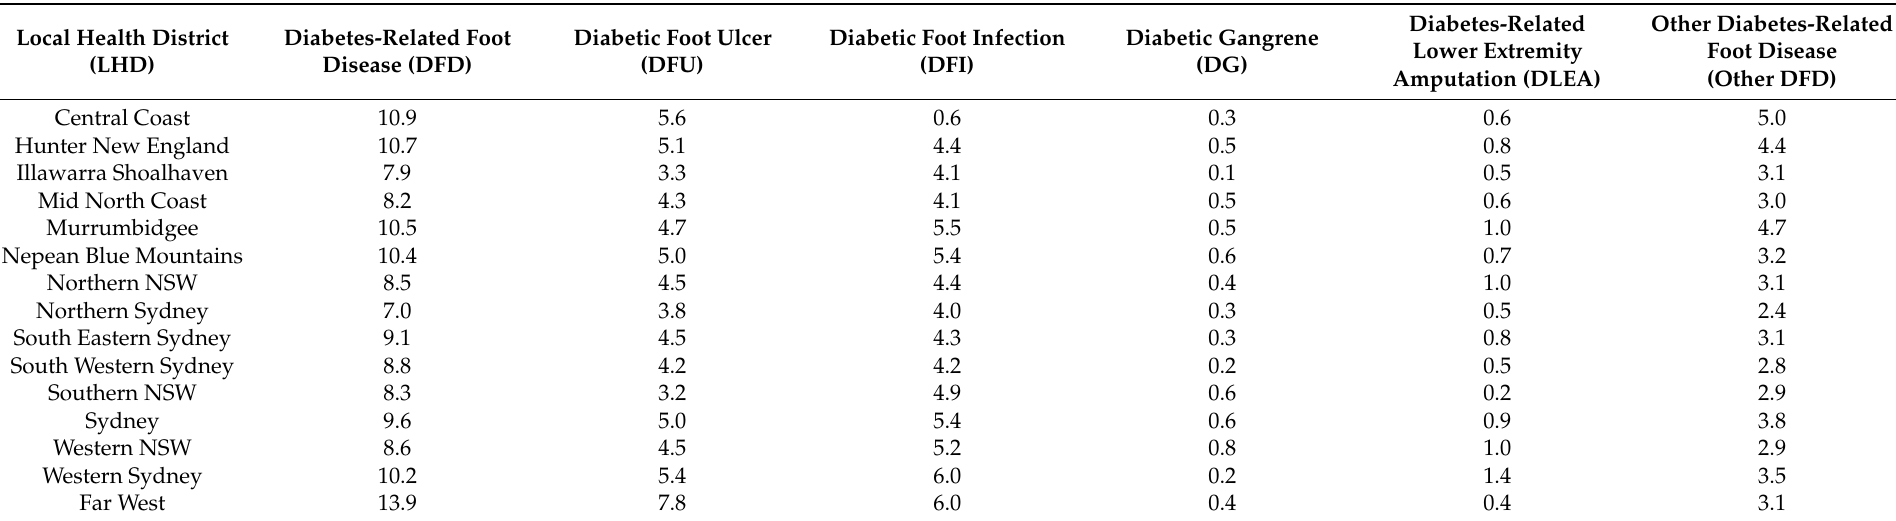
Note: ˆ Age standardised to the 2001 Australian standard population